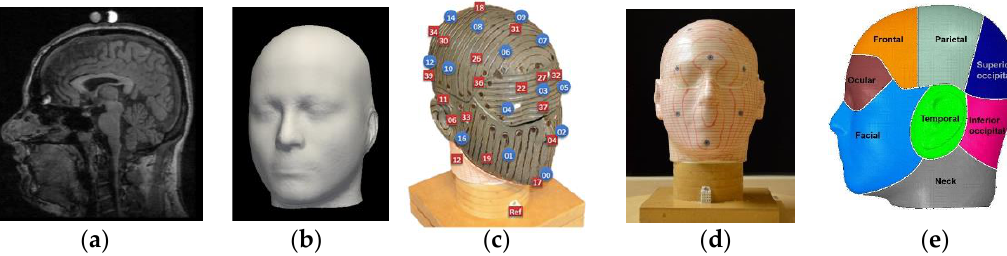
Figure 1. ( a ) Slice of head scan [32]; ( b ) average head shape obtained from magnetic resonance imaging (MRI) scans using shape-modeling approach; ( c ) manikin inner layer with marked thermal-sensor locations and sweat openings; ( d ) thermal manikin; ( e ) manikin measurement zones.